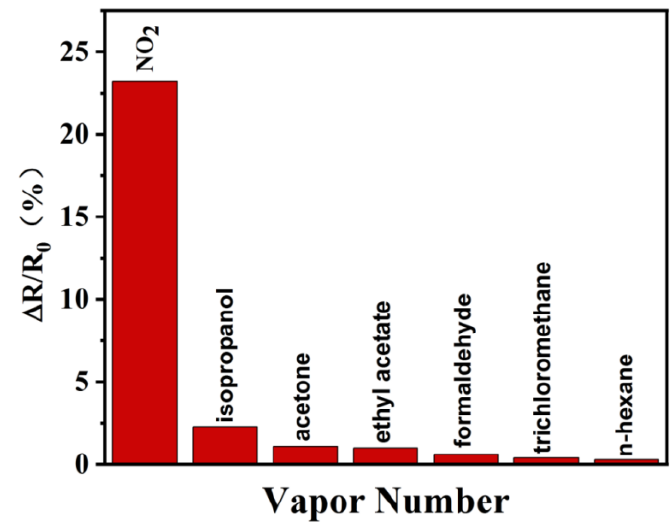
Figure 12. Selectivity toward different kinds of gases.